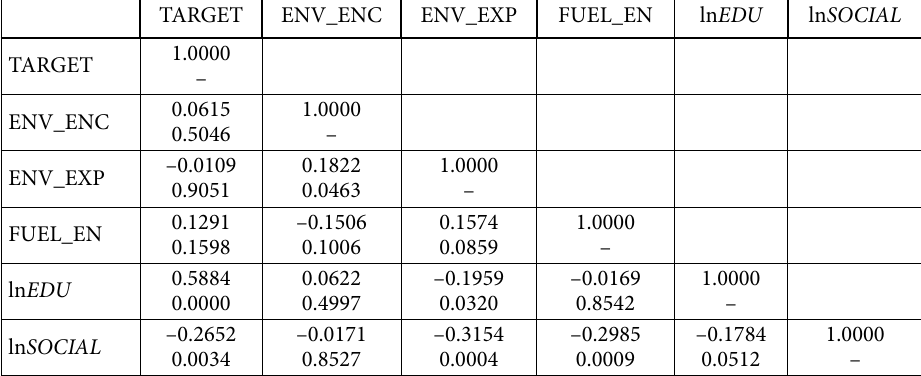
Table 4. Covariance analysis (source: author’s own calculation)